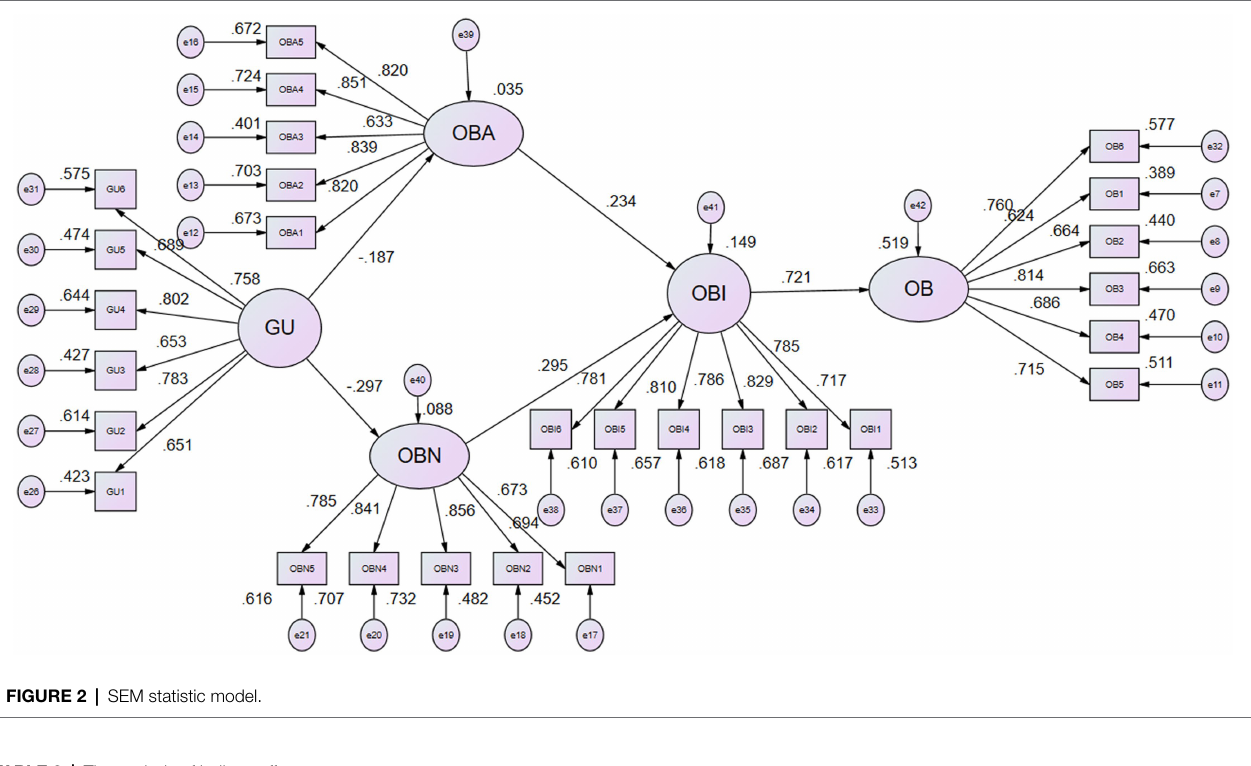
TABLE 8 | The analysis of indirect